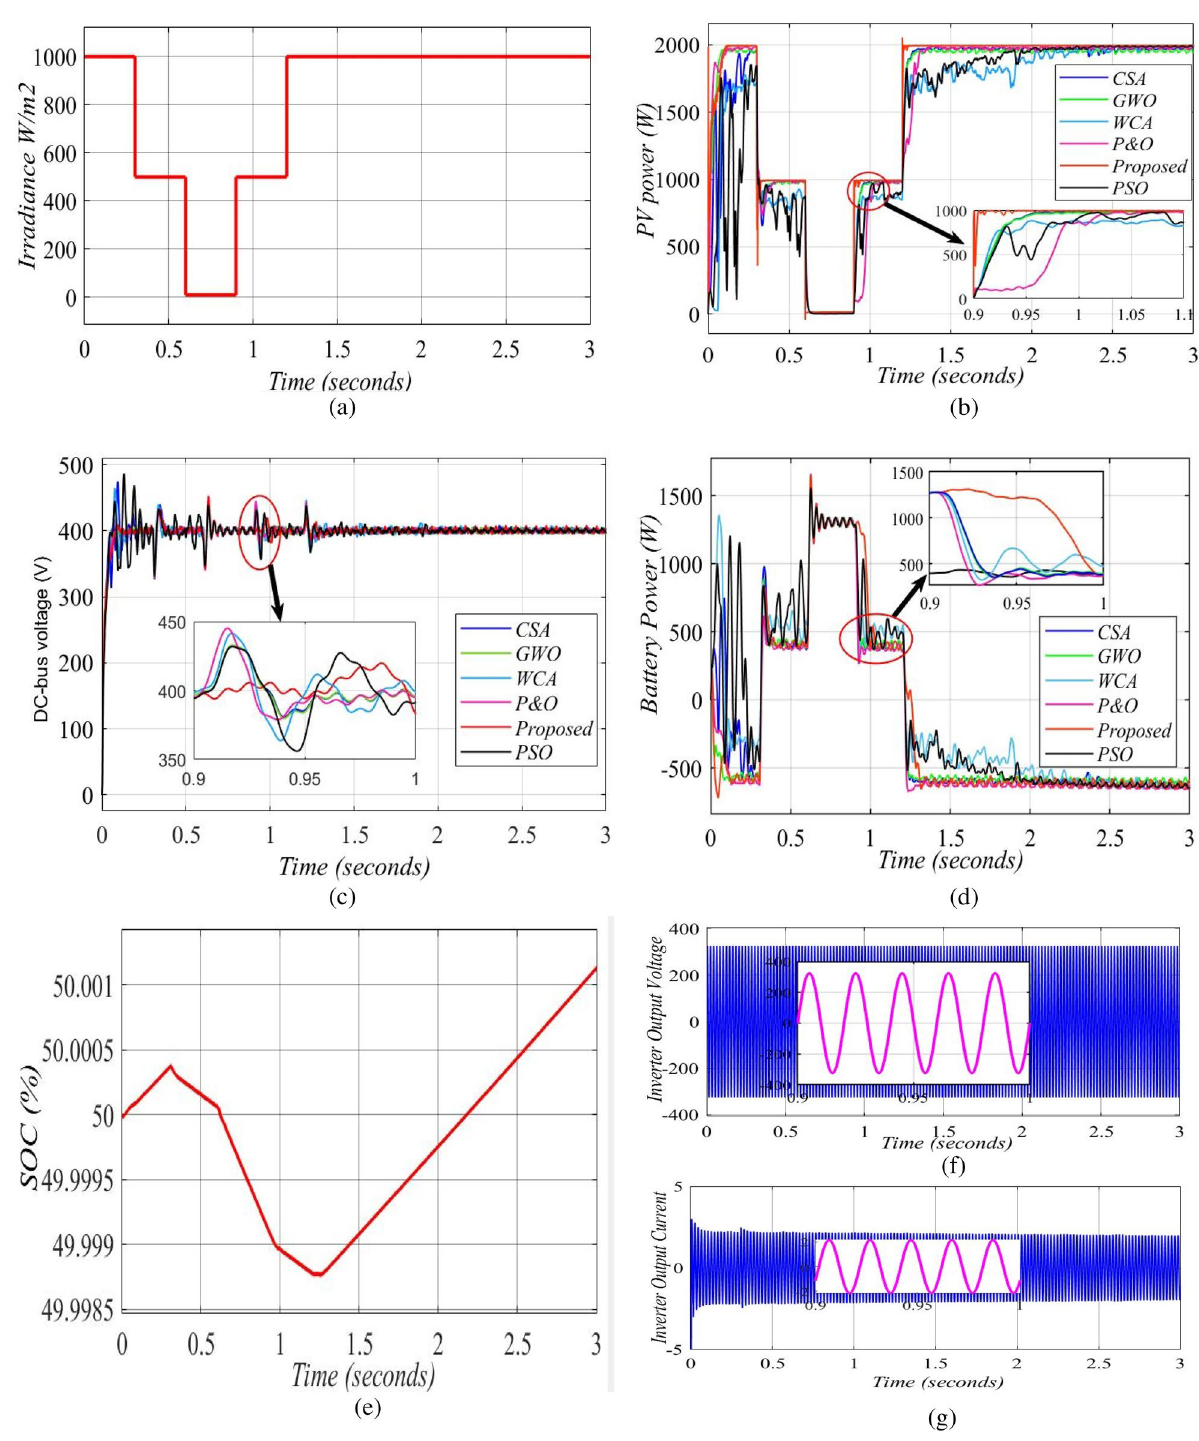
Figure 13. Simulation output of radiation changes in case 1: ( a ) irradiance; ( b ) PV system output power; ( c ) DC-Bus voltage output; ( d ) battery power; ( e ) state of charge (%); ( f ) inverter output-voltage; ( g ) inverter